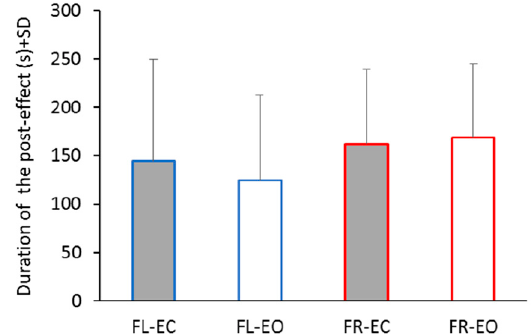
Figure 3. Duration of the post-stimulation effect on the ML CoP position. The bars with a blue outline refer to the fast left (FL) condition, and the bars with a red outline to the fast right (FR) condition. Grey filling refers to EC, white filling to EO. There was no difference in the duration of the post-effect regardless of the asymmetry of the stimulation-cycle profile or of the visual condition.